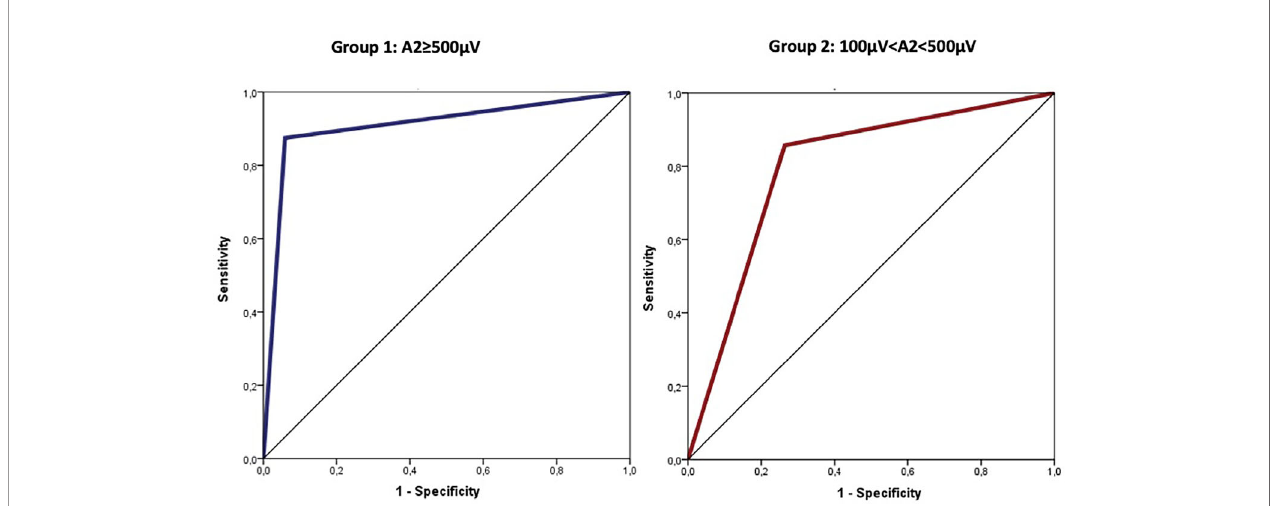
FIGURE 3 | Cut-off values for amplitude reduction with optimal sensitivity and speci fi city were − 77% in group 1 ( ≥ 500 µV) and − 15% in group 2 (between 100 and 500